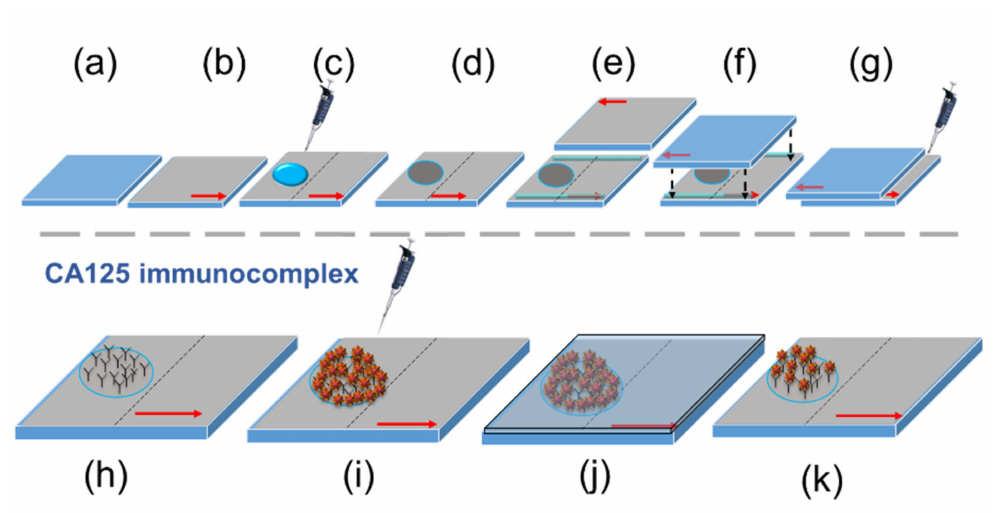
Figure 2. The LCLC-based protein detection and immunoassay platform. A cleaned optical glass substrate ( a ) was coated with PI SE-150 and rubbed unidirectionally ( b ). A 30 µ L aqueous solution of BSA or anti-CA125 antibody was dispensed on the rubbed PI-coated surface ( c ) and allowed to dry at 30 ◦ C for 30 min ( d ). After rinsing with DI water, the 15- µ m spacer was mixed with the epoxy resin AB glue and distributed on two parallel edges of the optical glass substrate ( e ), followed by LC cell assembly with another protein-free PI-coated glass substrate with antiparallel rubbing direction ( f